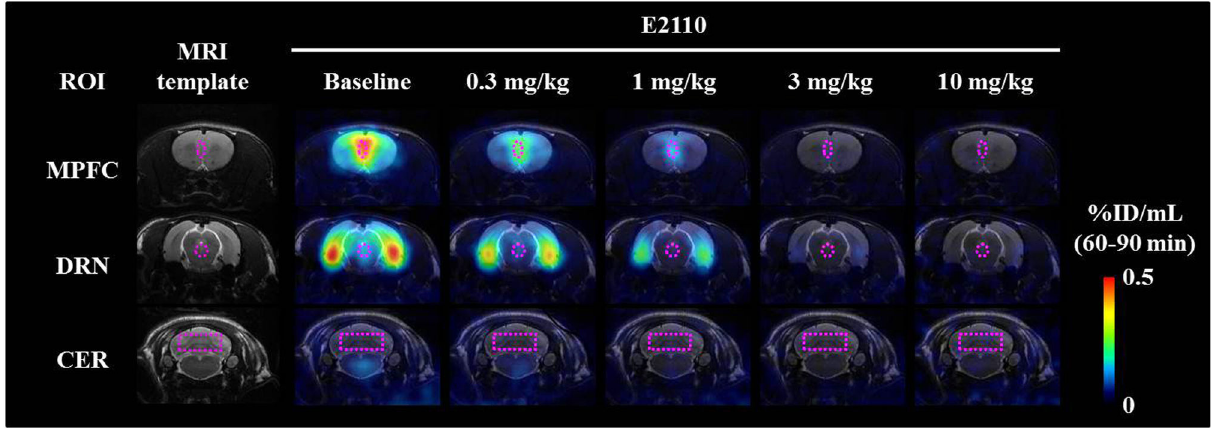
Figure 4. Representative PET images illustrating distribution of [ 11 C] WAY-100635 in rat brains at baseline and after oral administration of E2110. PET images were generated by averaging dynamic data at 60-90 min after intravenous radiotracer injection, and were overlaid on the MRI template shown in the far left column. Coronal brain sections shown here were obtained at 1.0 mm (top row), -7.8 mm (middle row) and -12.5 mm (bottom row) from the bregma. ROIs (dotted lines) were defined on the MPFC (top row), DRN (middle row) and cerebellum (CER; bottom row). The radiotracer retention was presented as a percentage of the injected dose per unit tissue volume